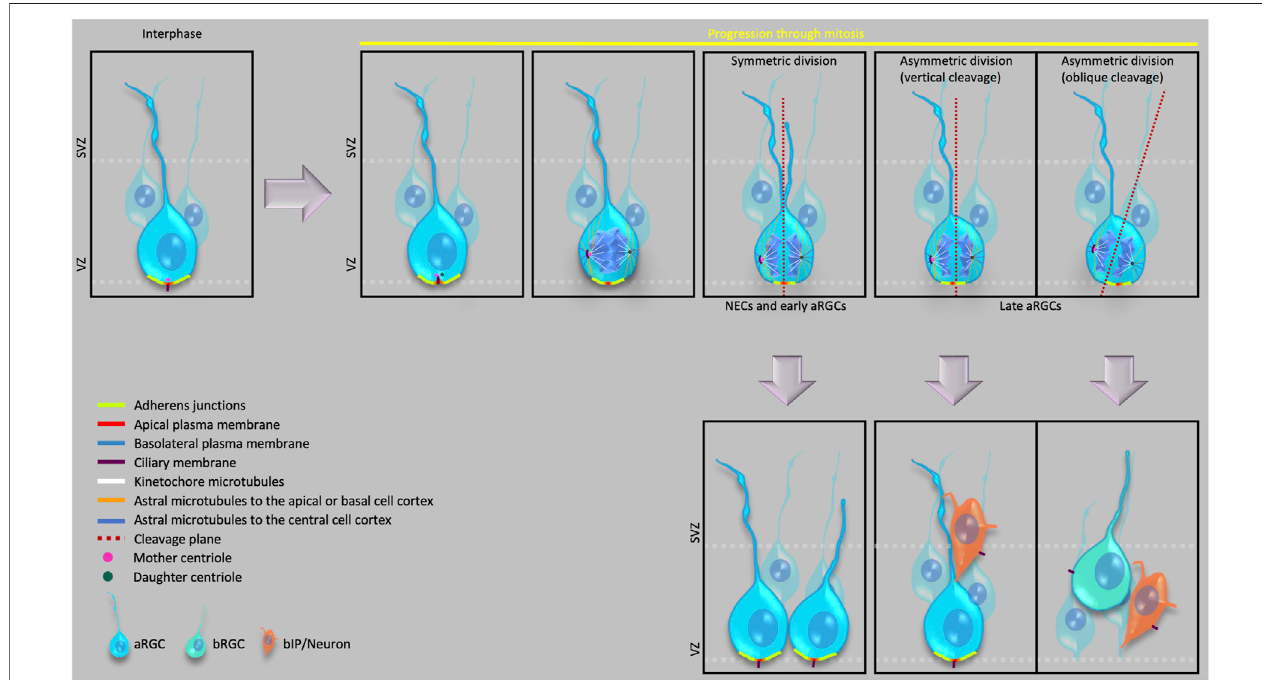
FIGURE 1 | Cell biological features of apical progenitors and their various modes of division.